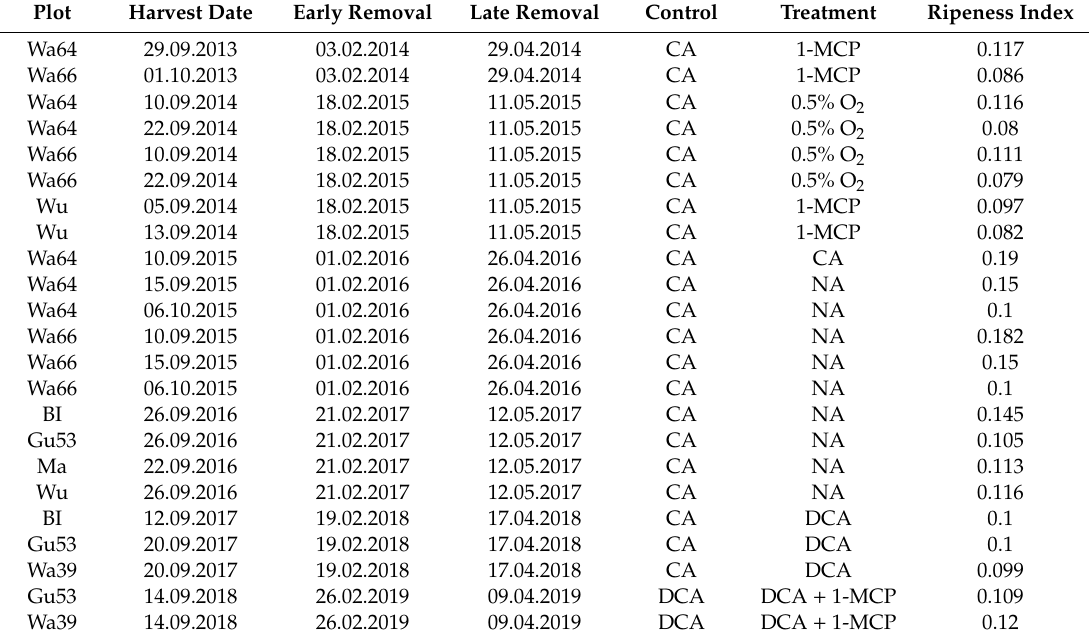
Table 1. Harvest dates and dates of storage removal of Malus × domestica cv. Ladina apples from di ff erent locations, years, and treatments, including estimated ripeness expressed as Streif index. (Streif index = firmness (kg / cm 2 ) / (starch degradation (1–10) * total soluble solids ( ◦ brix)). Where not indicated otherwise, fruits were stored under controlled atmosphere (CA) conditions at 1 ◦ C, 1% CO 2 , 1% O 2 , and 92% relative humidity (control